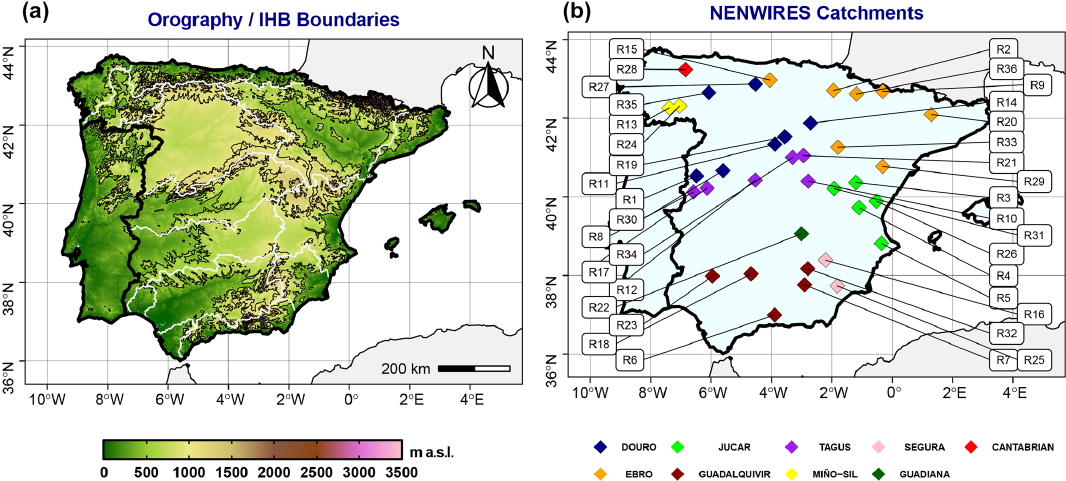
Figure 1. Panel (a) shows the orography of the Iberian Peninsula (IP), and panel (b) outlines the NENWIRES reservoirs grouped by Iberian hydrological basins (IHBs). In panel (a) , light blue contours represent the IHB boundaries in continental Spain, and black contours outline the altitude above sea level (at 500m